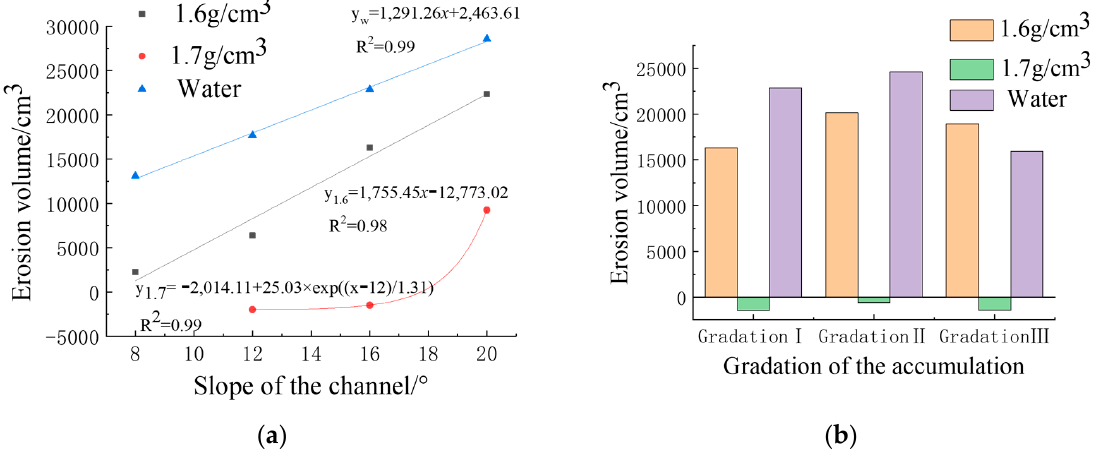
Figure 10. Lateral erosion volume. ( a ) Erosion volume under different slope gradients. ( b ) Erosion volume under different graded accumulations.